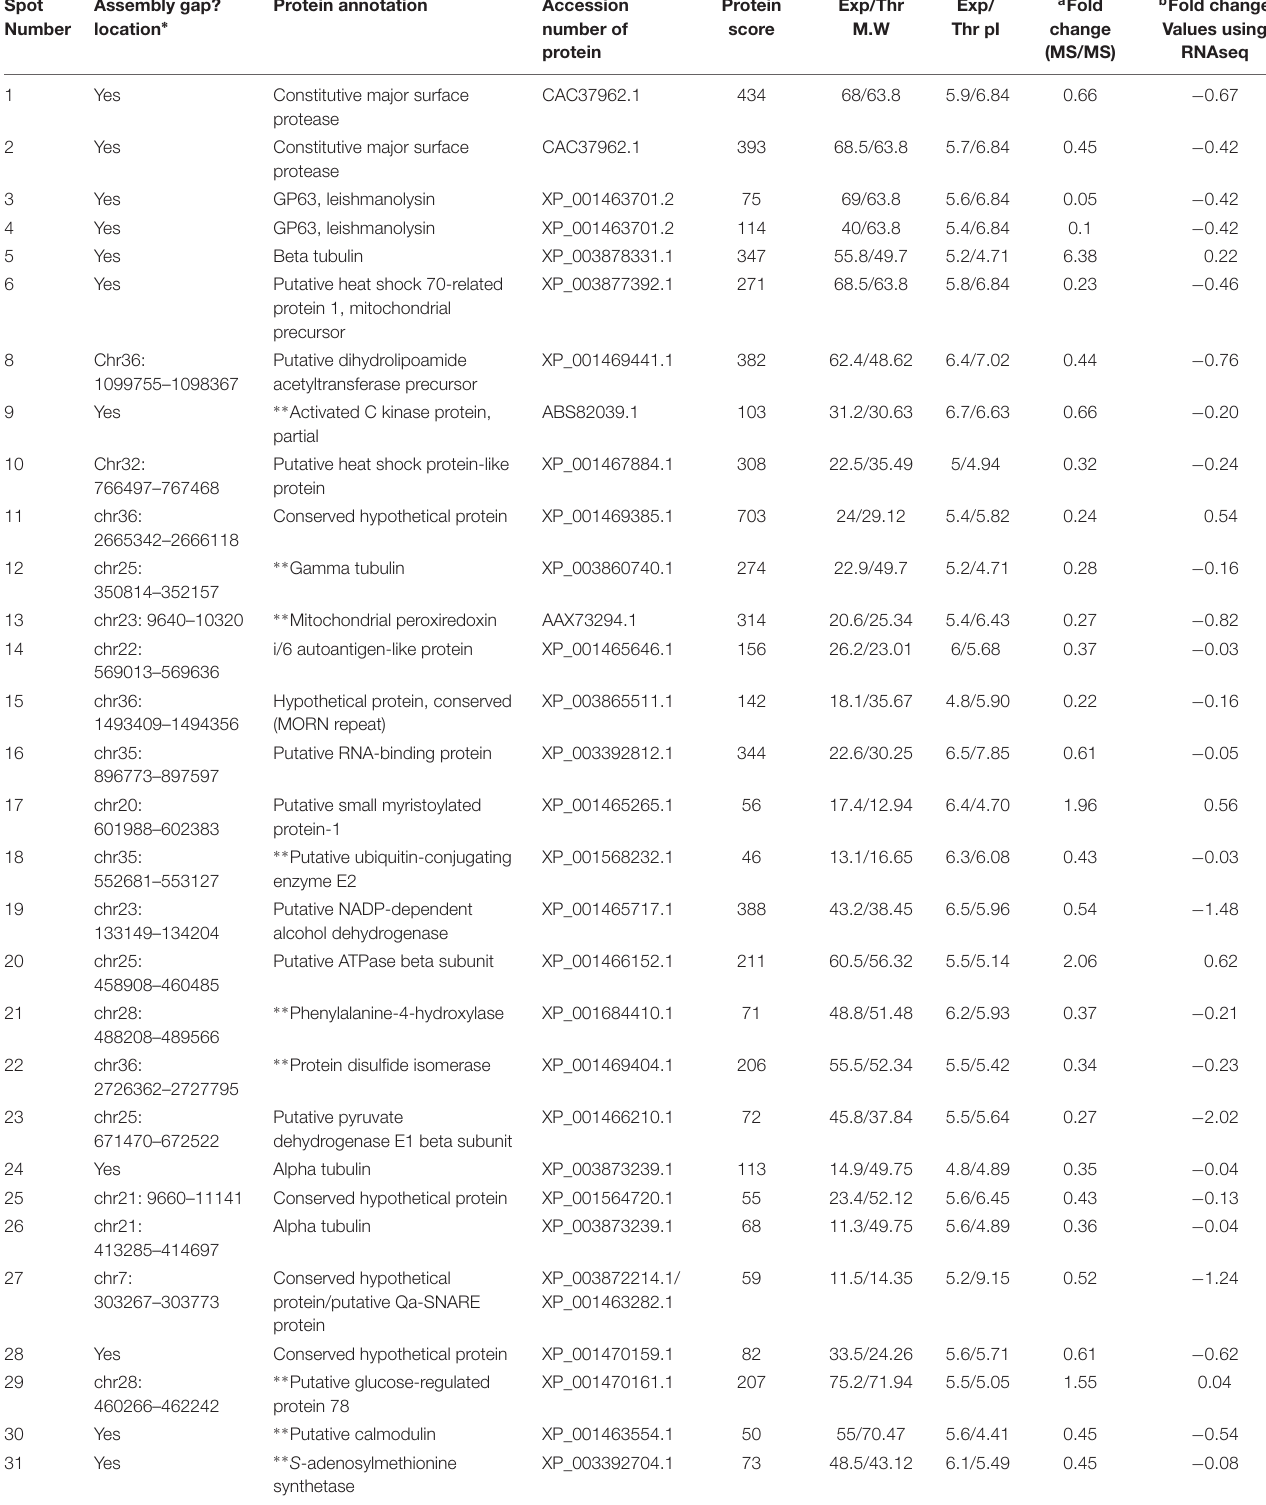
TABLE 3 | List of proteins differentially expressed ( ≥ 1.5-folds) between early and late passages identified by MALDI-ToF MS/MS. Spot Assembly gap? Number location